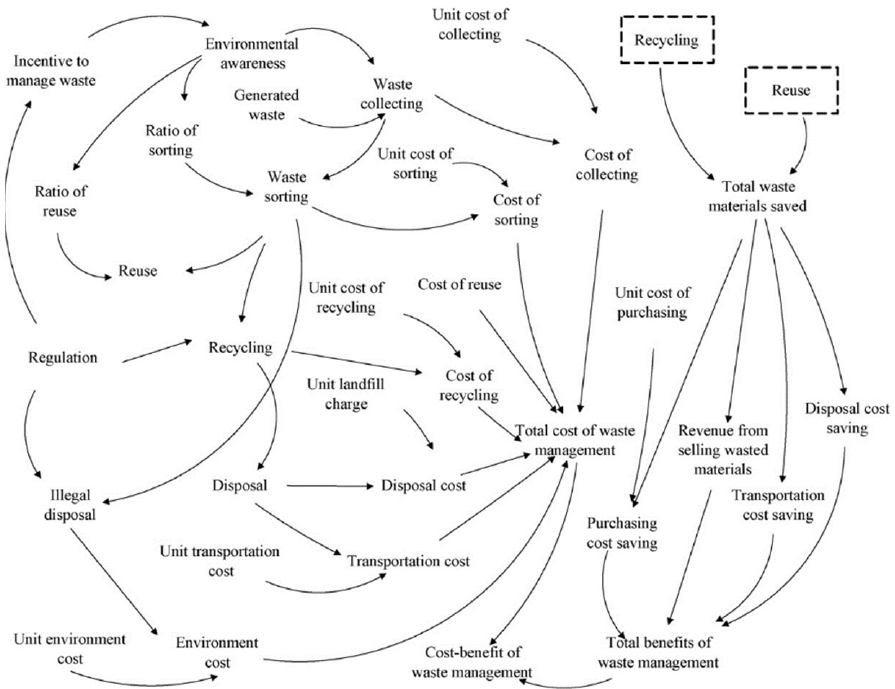
Figure 7. Visual representation of the model created to determine if increased waste levies would increase waste minimization [44] .